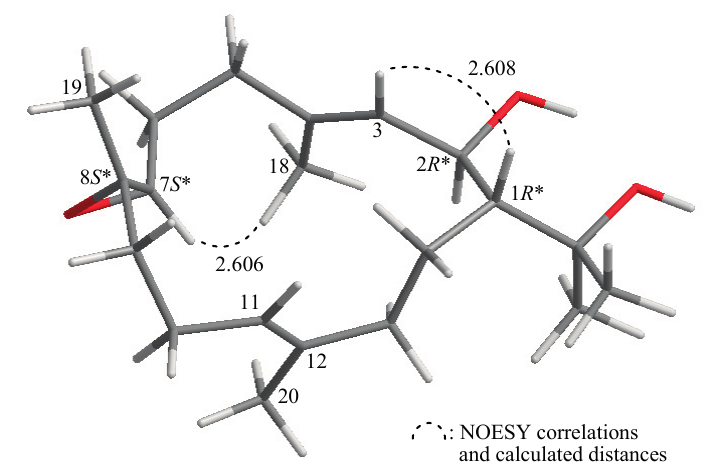
Figure 2. The computer-generated model of 1 using MM2 force field calculations and the calculated distance (Å) between selected protons with key NOESY